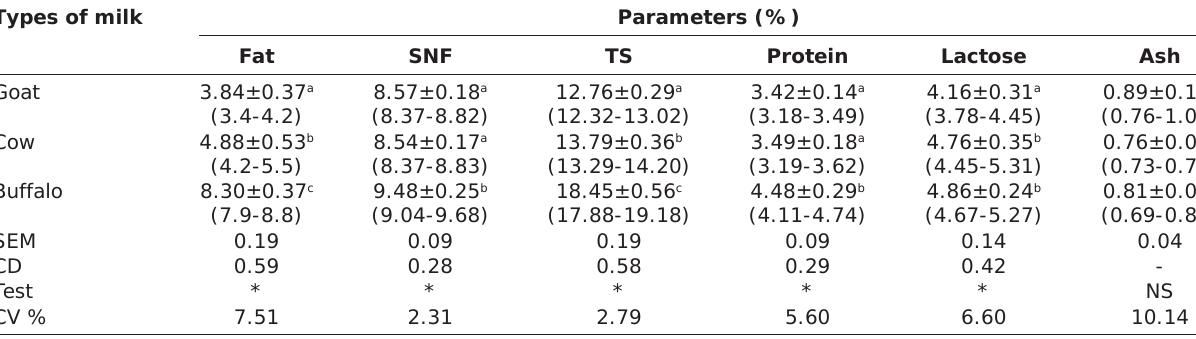
Table-1: Gross composition of goat, cow, and buffalo milk. Types of